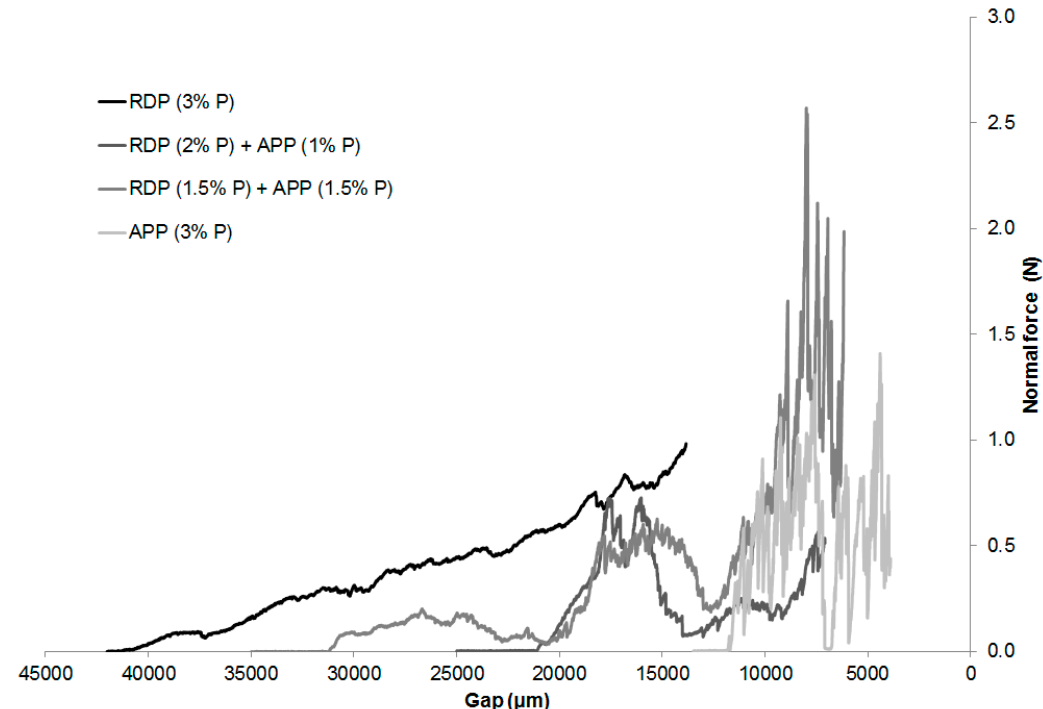
Figure 8. Compression strength results of SPE and flame-retarded SPE chars.